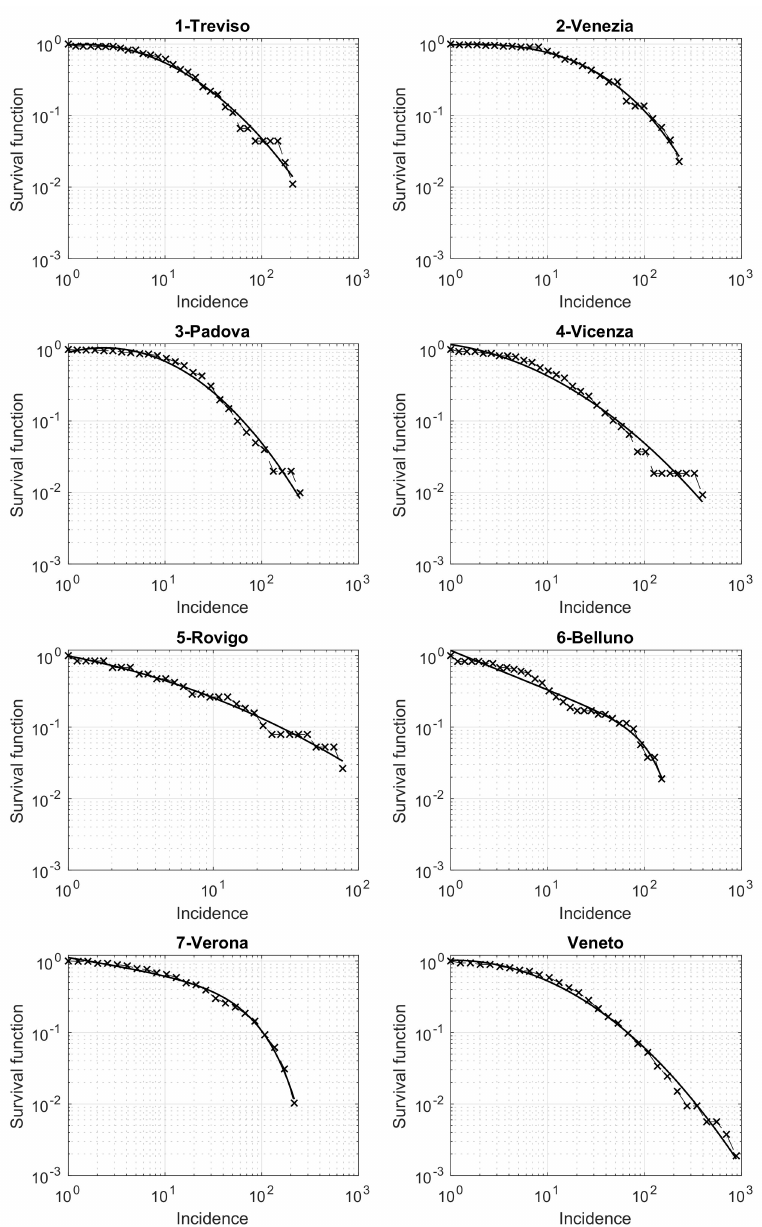
Figure 6. Survival function of the Veneto municipalities incidence in the period from 12 March to 15 May 2020, in a loglog scale. The best fit by the tapered Pareto model is shown by a continuous black